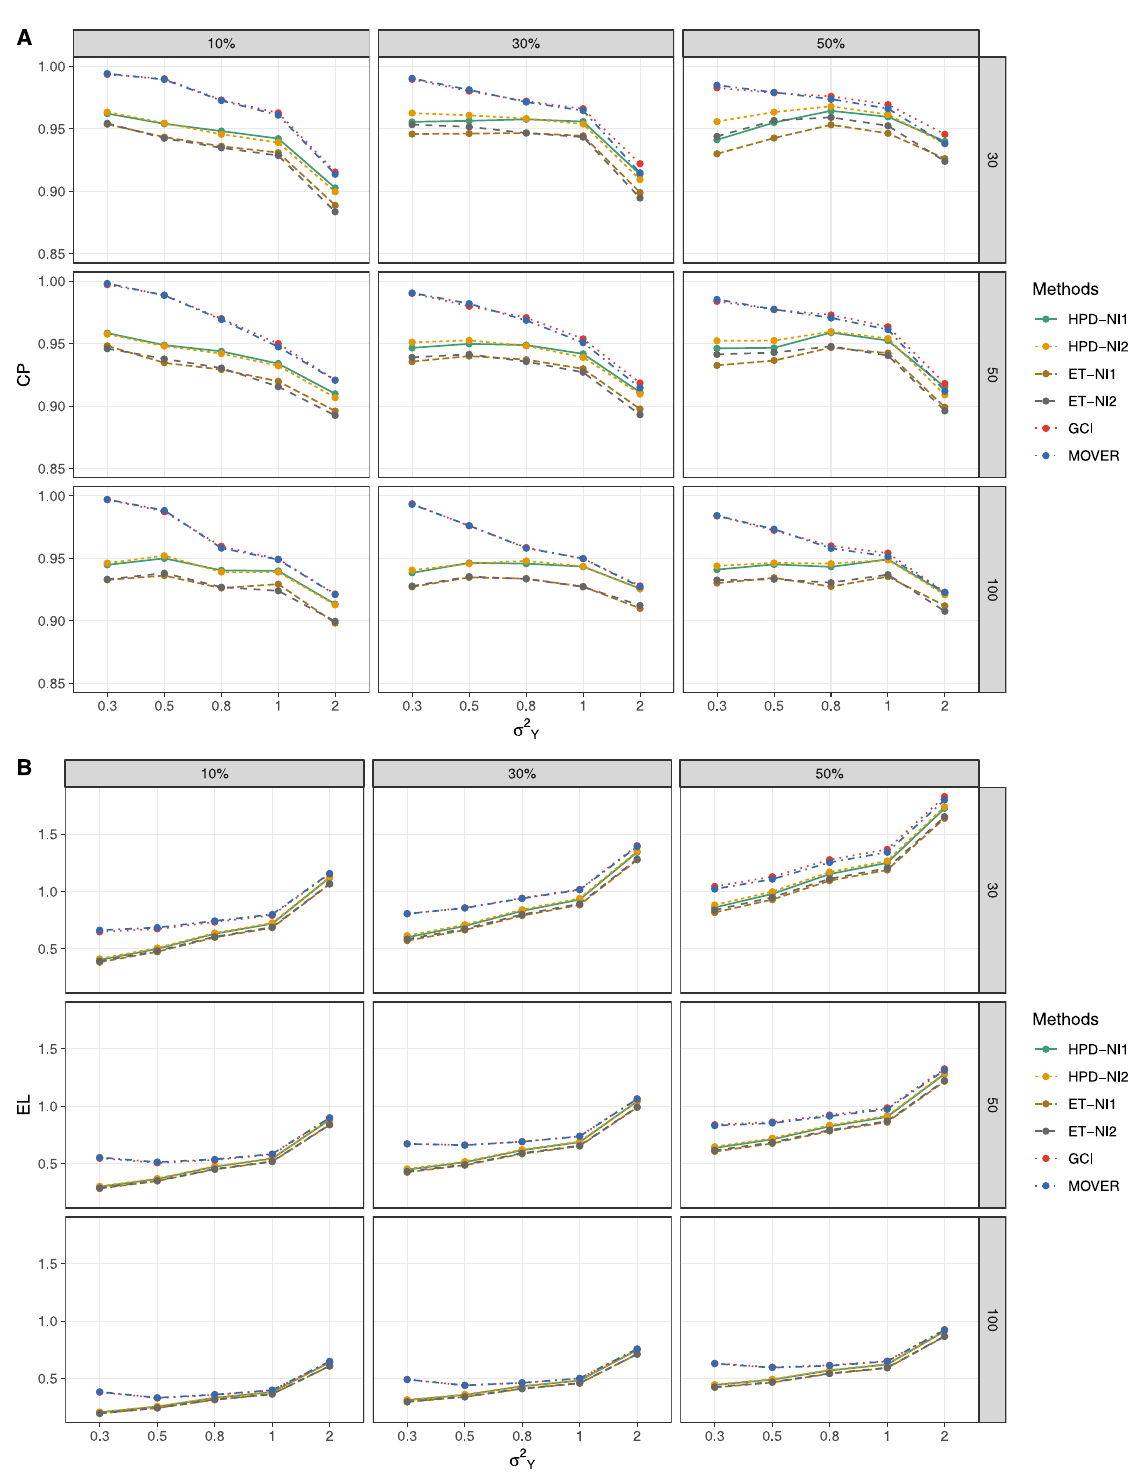
Fig 2. Performance measures of 95%CIs for θ : a = 5 (A) Coverage probabilities and (B) Expected lengths.